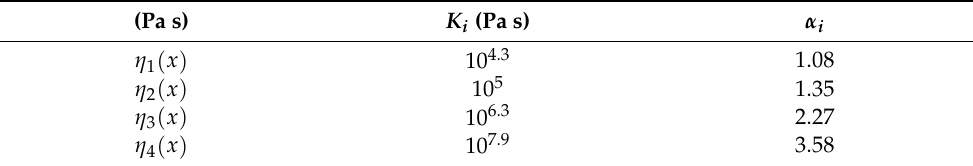
Figure 6. The dependence of 𝜀 ( a ) and 𝜉 ( b ) on the filler volumetric content x . The red lines are fitted based on the PTT model (Table 1). The associated equations are presented in each subplot.